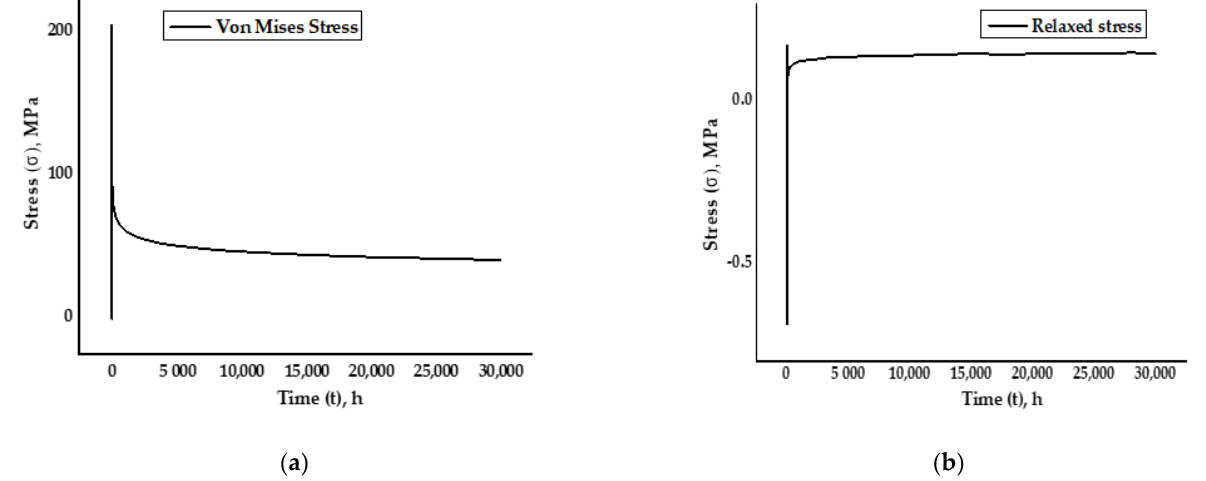
Figure 10. ( a ) Von Mises stress distribution. ( b ) Relaxed stress with the visco-elastic plastic run time of 30,000 h.